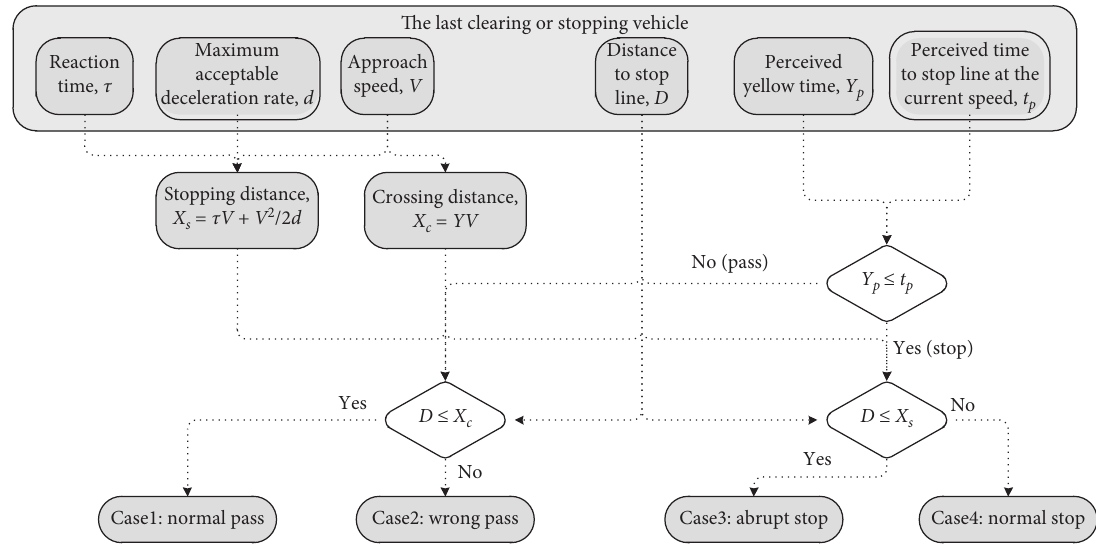
Figure 4: Classification of decision-making behavior. Table 2: Comparison of abnormal decision behavior with RLC and without RLC.